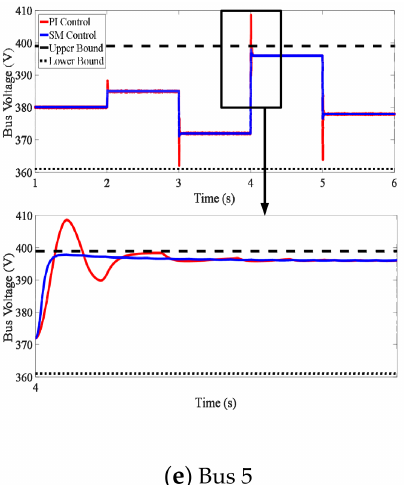
Figure 15. Bus voltages of the DC microgrid over a simulation period of 5 s with both PI and SM